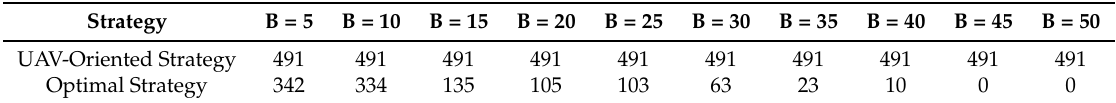
Table 7. The table shows total energy consumption of nonvisited CH robots depending on battery capacity of UAV in Figure